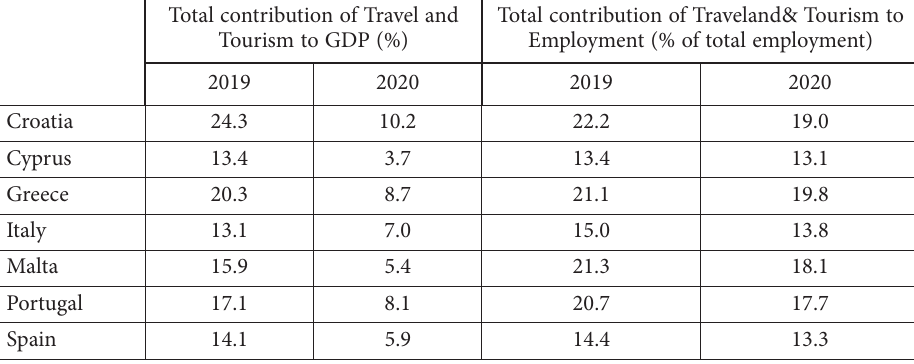
Table 2. Total contribution of Travel and Tourism to GDP (source: authors according to World Travel and Tourism Council, 2021) Total contribution of Travel and Total contribution of Traveland& Tourism to Tourism to GDP (%) Employment (% of total